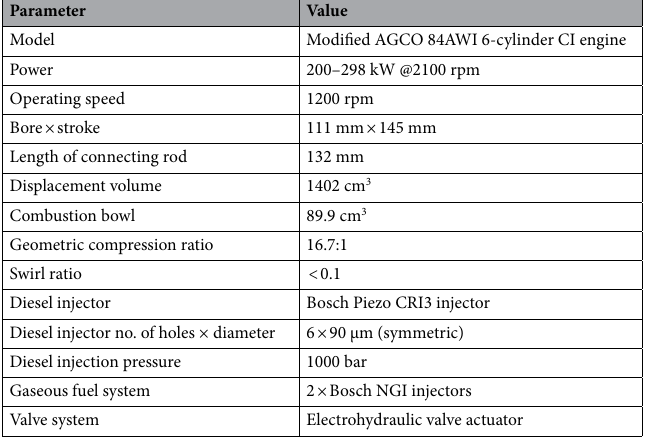
Table 1. Optical engine specifications.